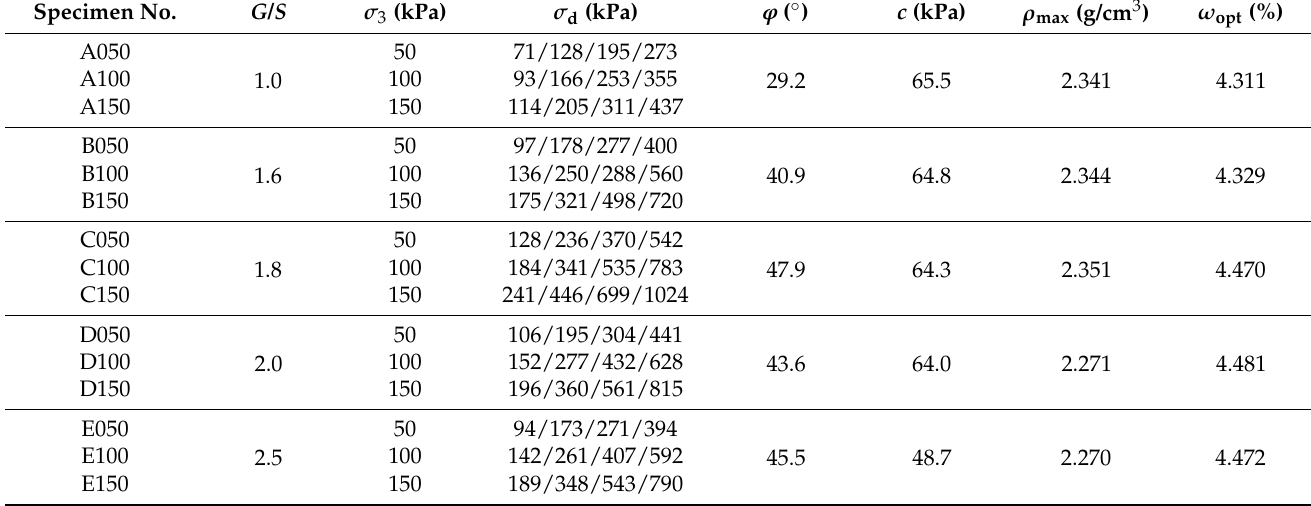
Table 2. The testing matrix of laboratory repeated load triaxial tests.